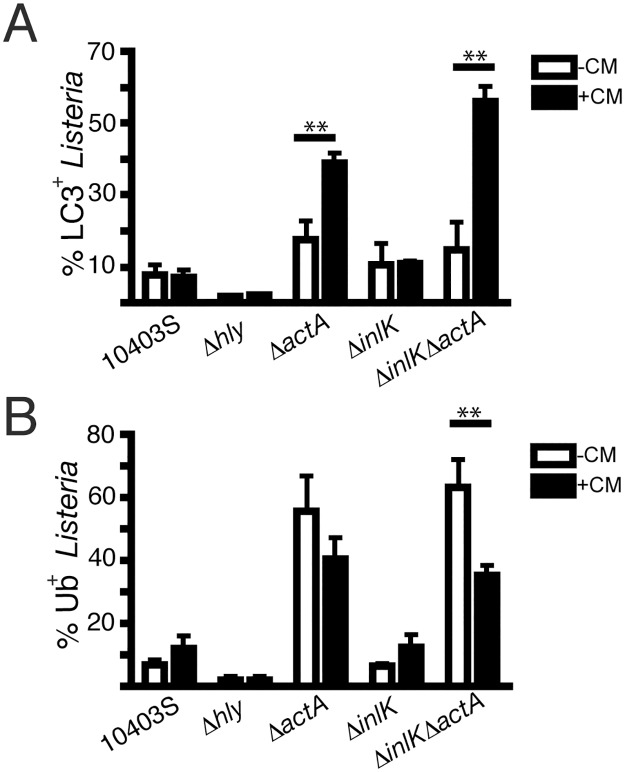
InlK does not prevent association of ubiquitinated proteins with L. monocytogenes strain 10403S.(A) Quantification of the percentage of L. monocytogenes that are LC3+ in RAW 264.7 macrophages infected with L. monocytogenes with the 10403S background: wildtype (10403S), LLO deficient (Δhly), ActA deficient (ΔactA), InlK deficient (ΔinlK) and InlK and ActA deficient (ΔinlKΔactA): 8 h (-CM) or 3 h, followed by 5 h CM treatment (+CM). **P value is < 0.001 (two-way ANOVA with Bonferroni correction). (B) Quantification of the percentage of L. monocytogenes that are LC3+ in RAW 264.7 macrophages infected with L. monocytogenes with the 10403S background: wildtype (10403S), LLO deficient (Δhly), ActA deficient (ΔactA), InlK deficient (ΔinlK) and InlK and ActA deficient (ΔinlKΔactA): 8 h (-CM) or 3 h, followed by 5 h CM treatment (+CM). ***P value is < 0.001 (two-way ANOVA with Bonferroni correction).